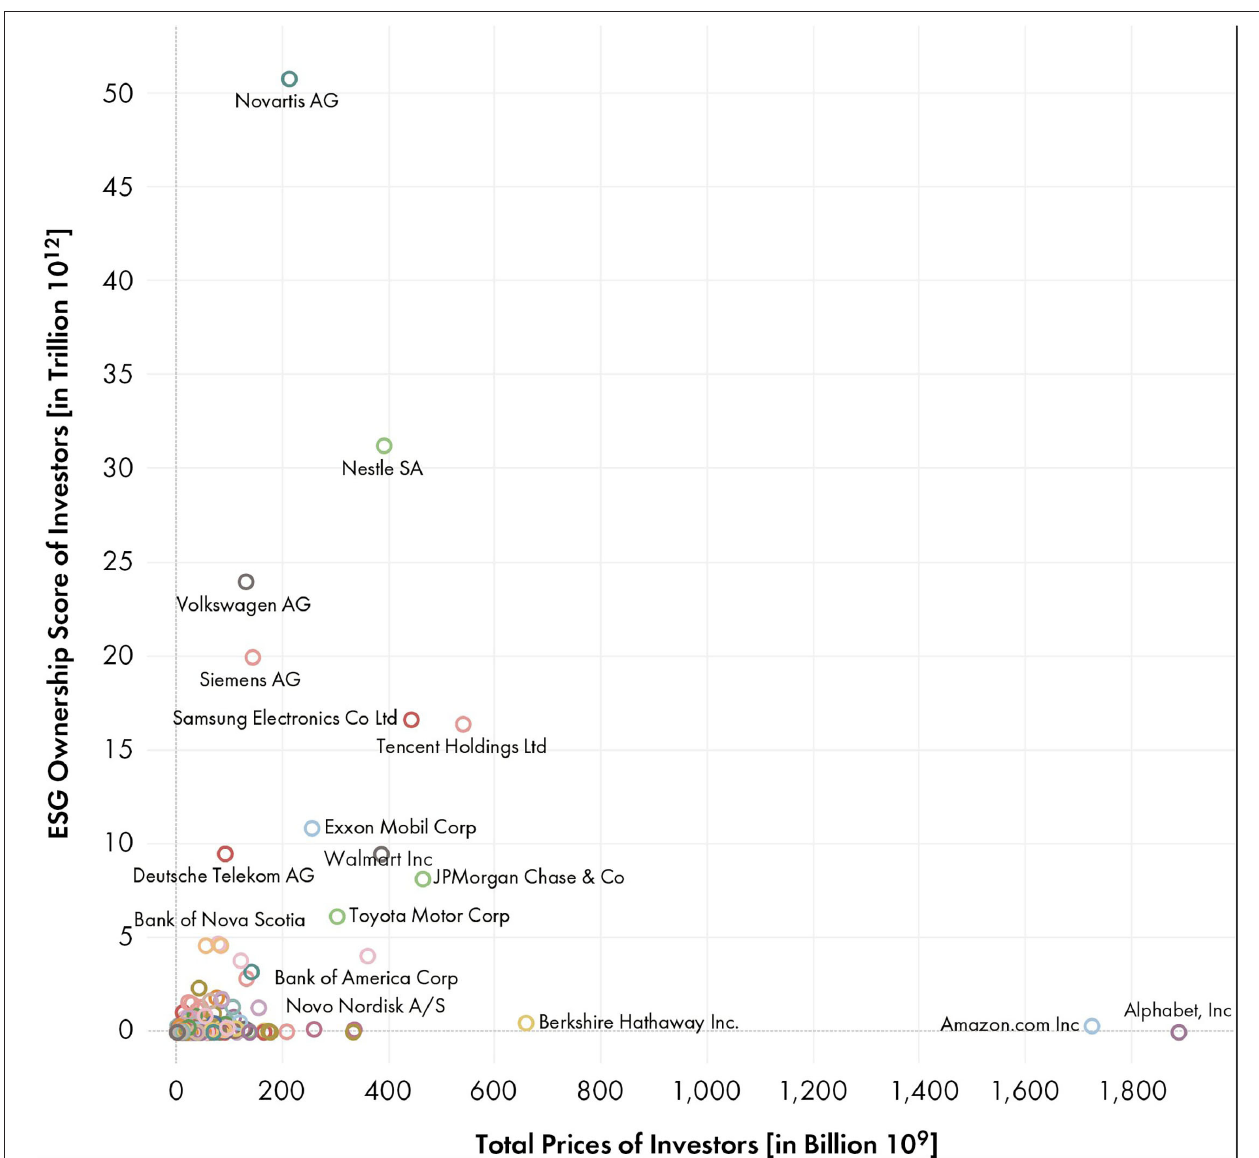
FIGURE 9 | Relation between investors’ total market price and ESG ownership ( n = 1,716).